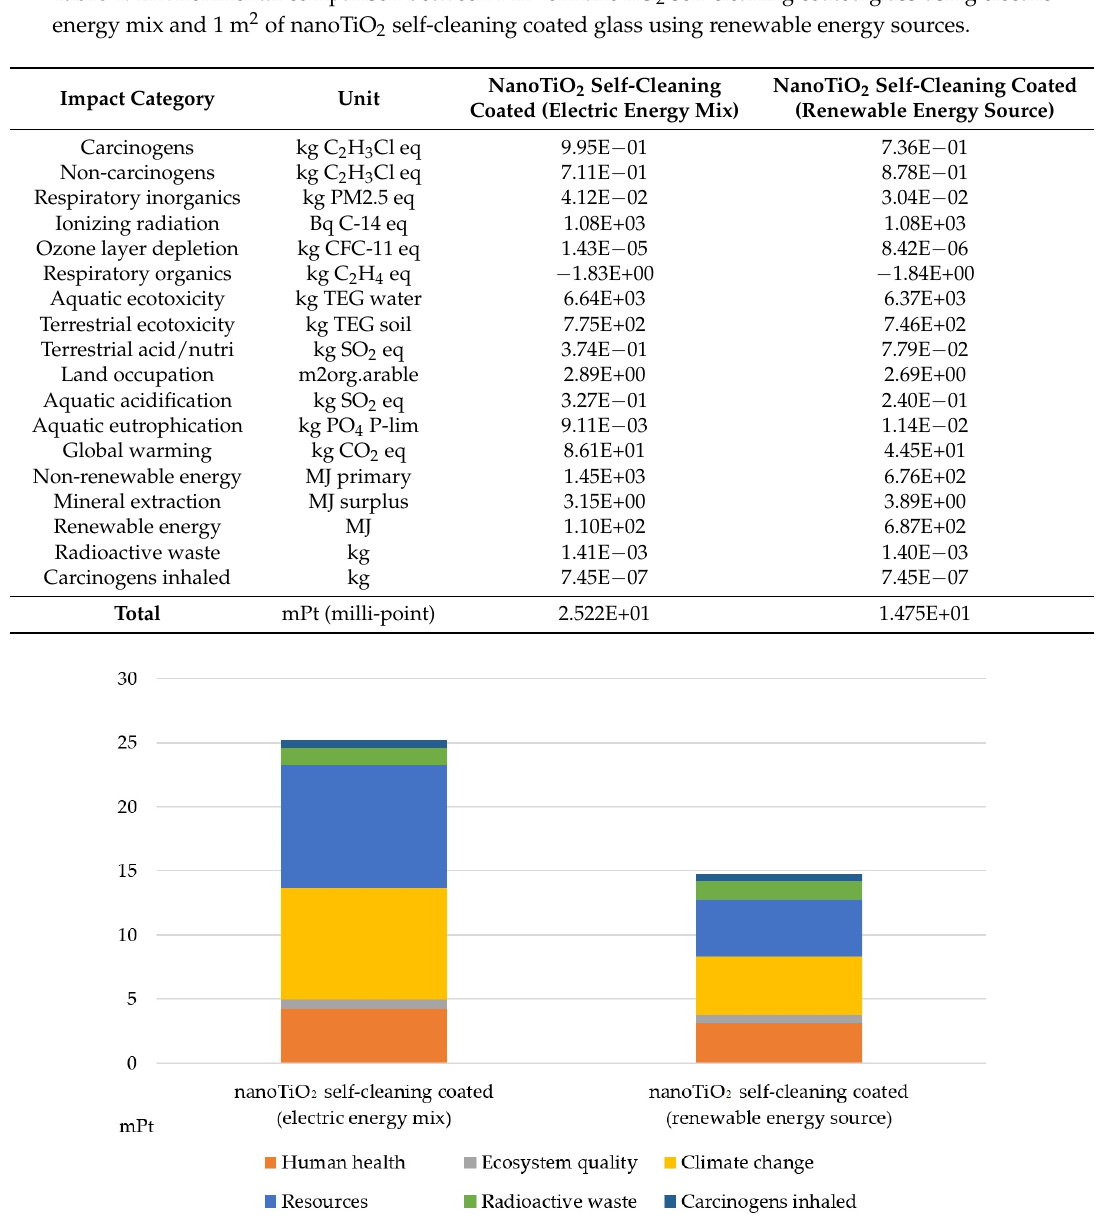
Figure 4. Environmental comparison between 1 m 2 of nanoTiO 2 self ‐ cleaning coated glass using electric energy mix and 1 m 2 of nanoTiO 2 self ‐ cleaning coated glass using renewable energy